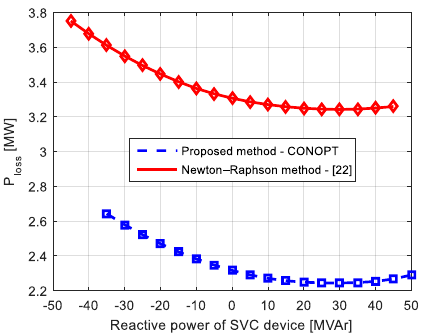
Figure 6. The impact of the reactive power of SVC devices located in node 9 on power system losses in the IEEE 9 test bus system.